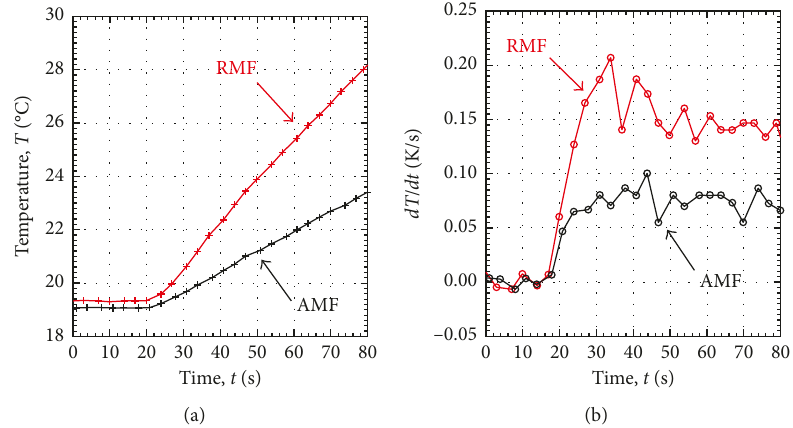
Figure 5: (a) Temperature of first 80s of heating for 244kHz and 2kA/m AMF and RMF, and (b) its corresponding time derivatives.